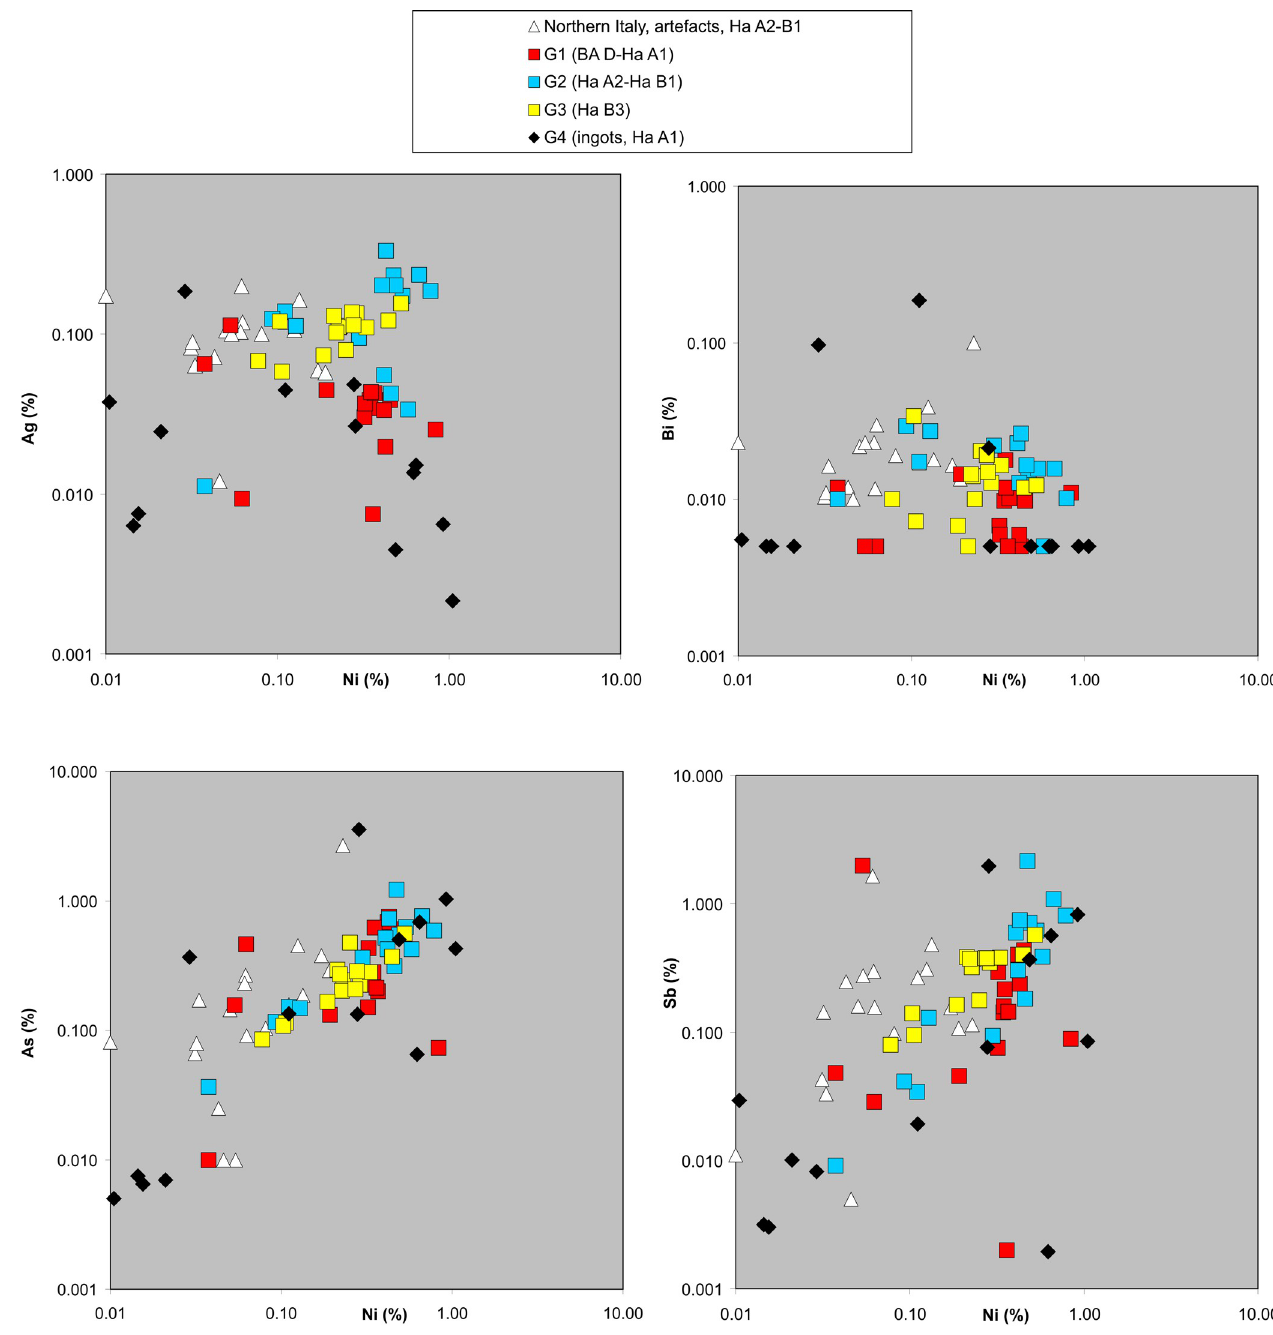
Fig 6. Trace element values of the artefacts under study compared to those of Northern Italian objects; The double logarithmic diagrams show the analytical results of the finds under study (squares), compared with those of objects which were found in Northern Italy (white triangles). The artefact data is from [20]. All values are given in weight % (chart: M. Mehofer, University